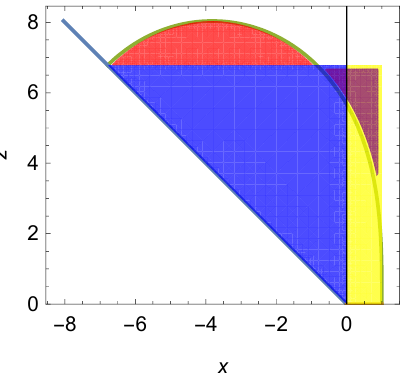
Figure 5 . The geometric interpretation of each term in the final expression of the reflected en- tropy (3.26). The first term corresponds to the yellow rectangle. The second term corresponds to the blue triangle and its bottom margin. The third term corresponds to the red region and the subtraction with the purple